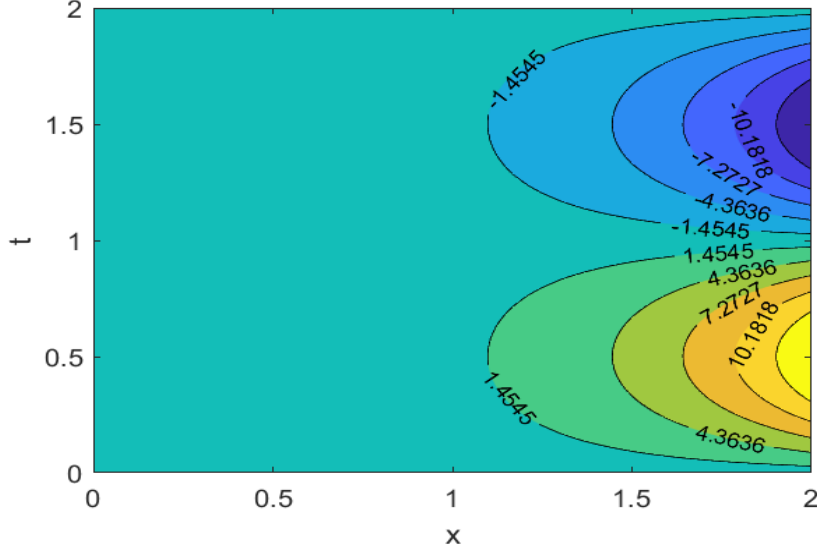
Figure 4. Contour plot of u ( x , t ) when α = 1.3, T = 2, L = 2, M = N = 256.